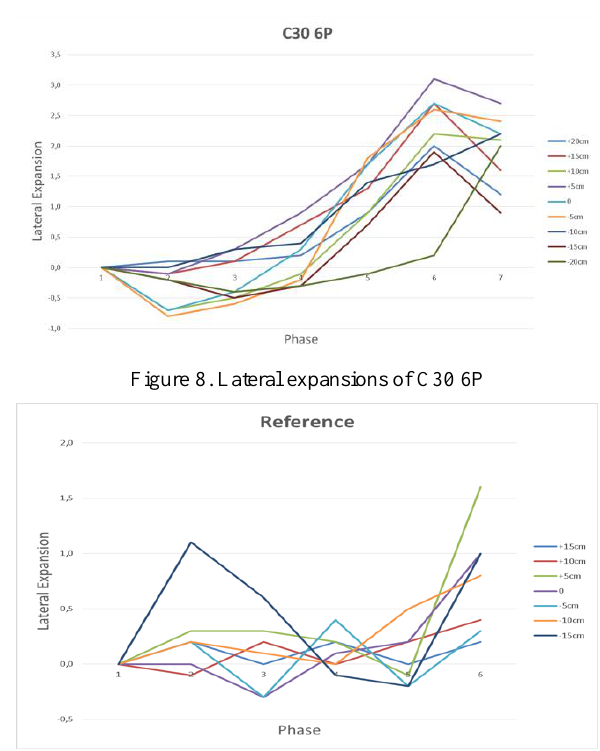
Figure 9. Lateral expansions of reference